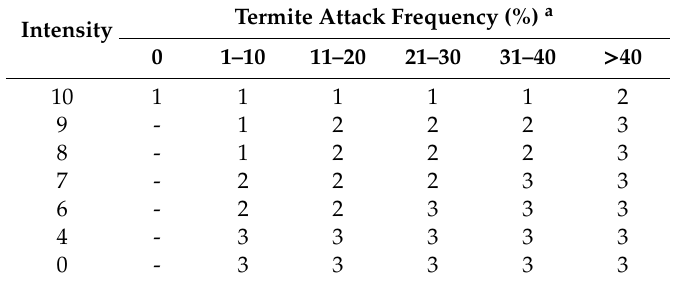
Table 3. Risk classification for the danger of termite attacks on the ground. Termite Attack Frequency (%) Intensity